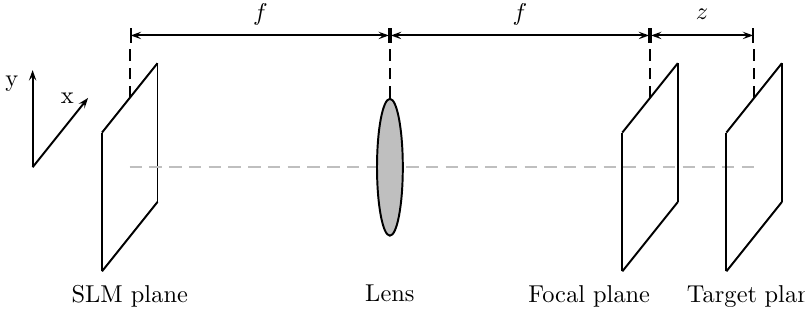
Figure 1. The optical path considered for the